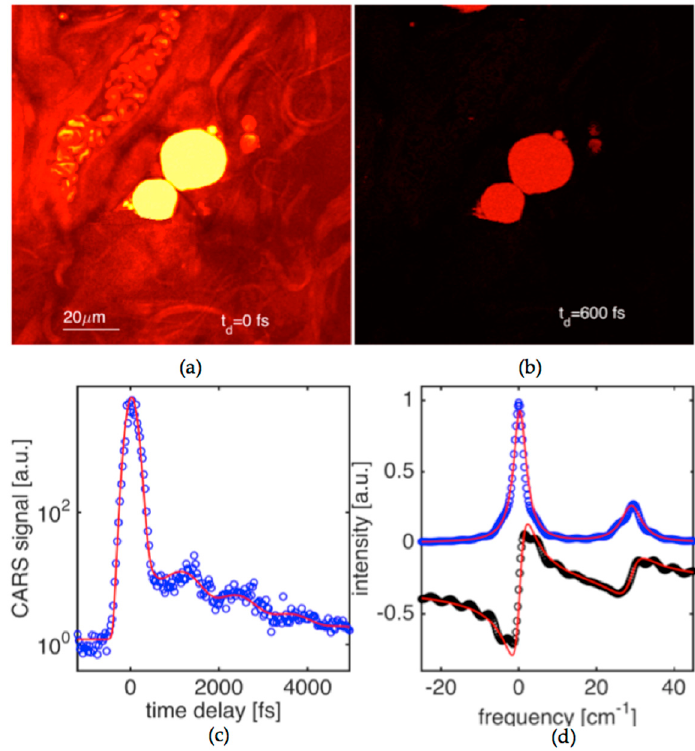
Figure 5. ( a ) CARS image obtained from the mouse dermis area at zero time delay between the driving E 1 , E 2 -pulsed fields and the probe field E 3 . Vibration at 1072 cm − 1 has been targeted; ( b ) CARS image the same area when the probe pulse was delayed by 600 fs; ( c ) Time-domain CARS signal obtained from the ~20 μ m diameter fat area located at the center of the mouse tissue for the image shown in Figure 5a. The red line represents the best fit to the data obtained by using Equations (3) and (4) and varying the corresponding line parameters (see text); ( d ) The real (black circles) and imaginary (blue circles) parts of χ (3) ( ω ) obtained using the experimental CARS transient shown in part ( c ) and Equation (5). The red line is a theoretical fit that makes use of the two-component Lorentzian function ( ν 1,2 = 4.1, 6.2 cm − 1 , 28 cm − 1 separation between components, A 1 / A 2 = 13:4).